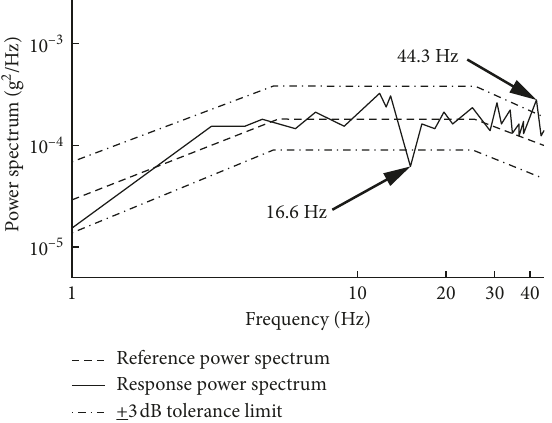
Figure 12: After resonant suppression by the digital filter.